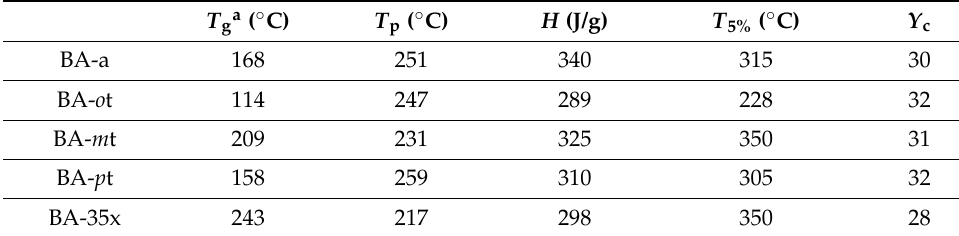
Table 1. Thermal characterization of substituted polybenzoxazines